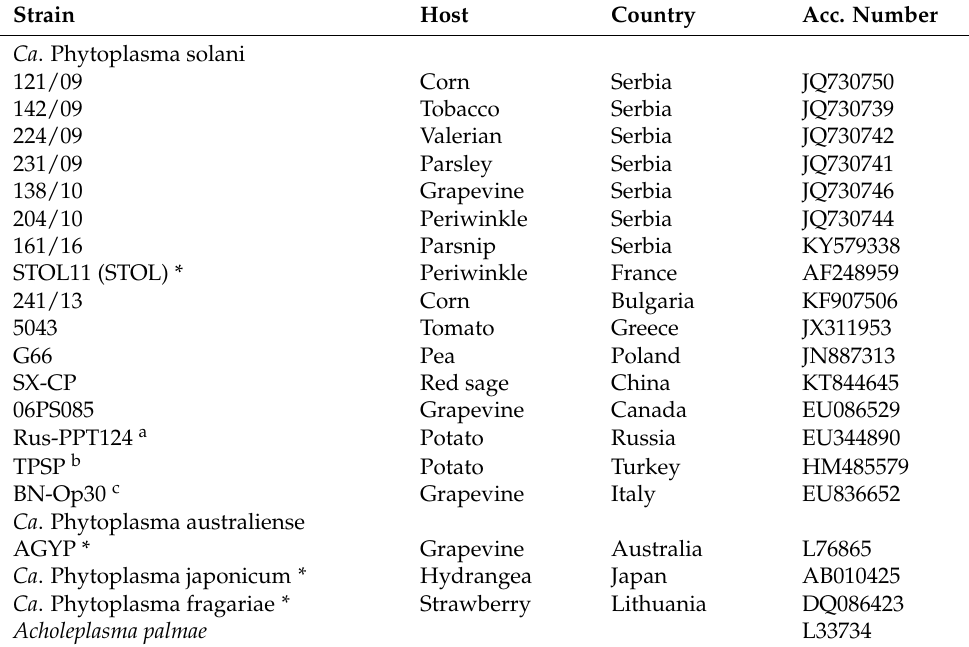
Table 1. Strains used for phylogenetic analysis. Strain